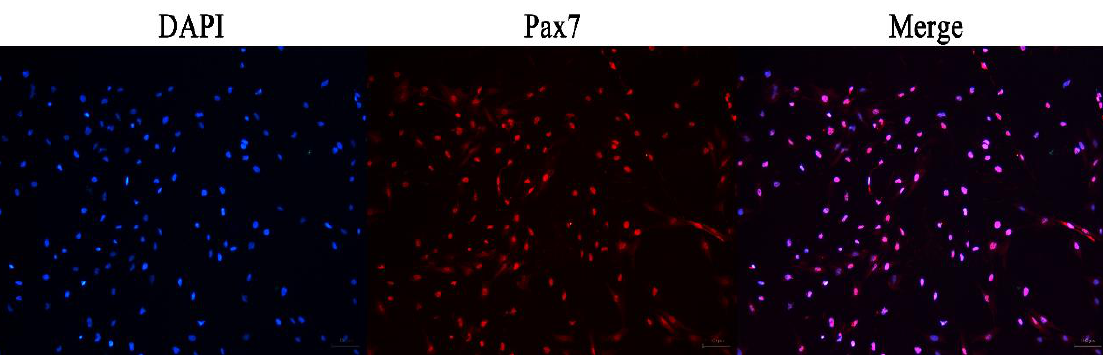
Figure 1. Micrographs of primary equine SCs. ( A ) just attached to the wall; ( B ) 24 h after isolation; ( C ) 48 h after isolation (typical SCs, with high refractive index and spindle shape); ( D ) 72 h after isolation (50 μ m).